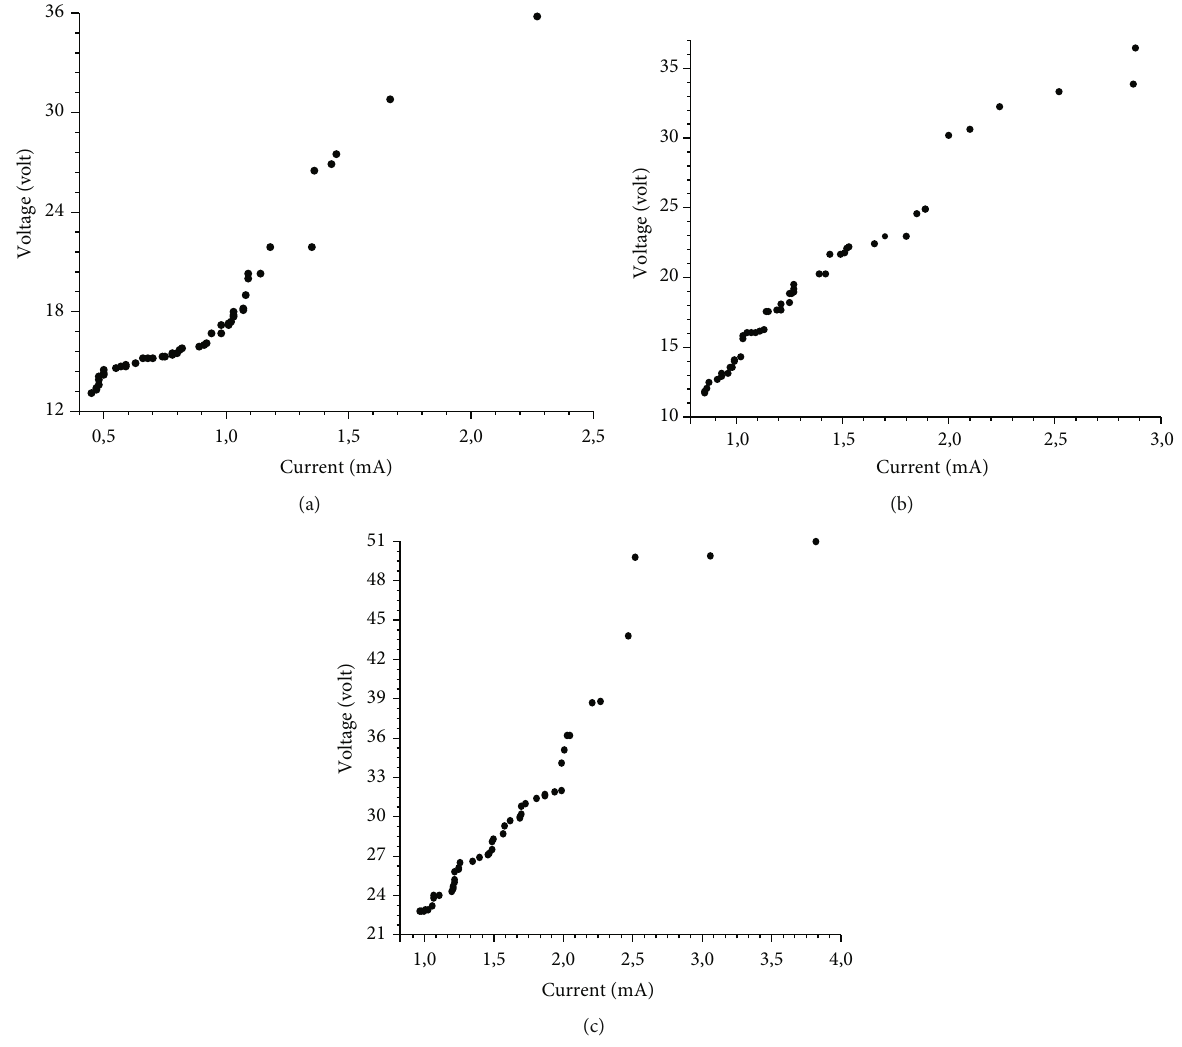
Figure 6: Curve I-V piezoelectric: (a) 28 pieces; (b) 70 pieces; and (c) 90 pieces. Table 2: Power and electric energy generated by piezoelectric. Piezoelectric quantity